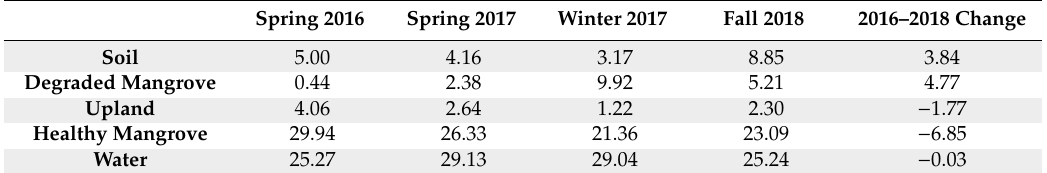
Table 3. Class coverage area (km 2